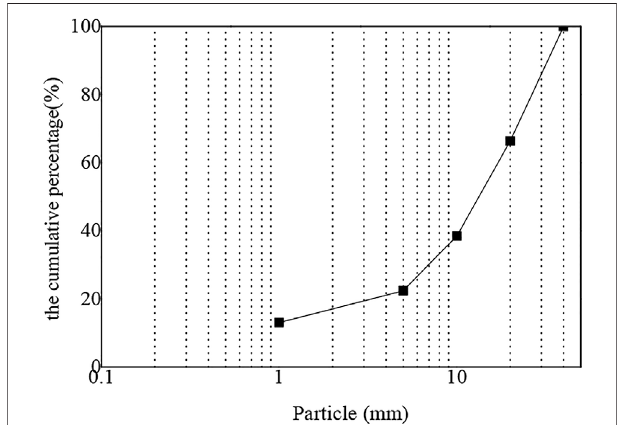
FIGURE 1 | Aggregate grading curve.